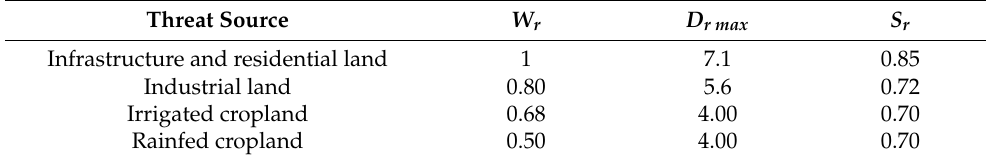
Table 1. Parameters of different threat sources.